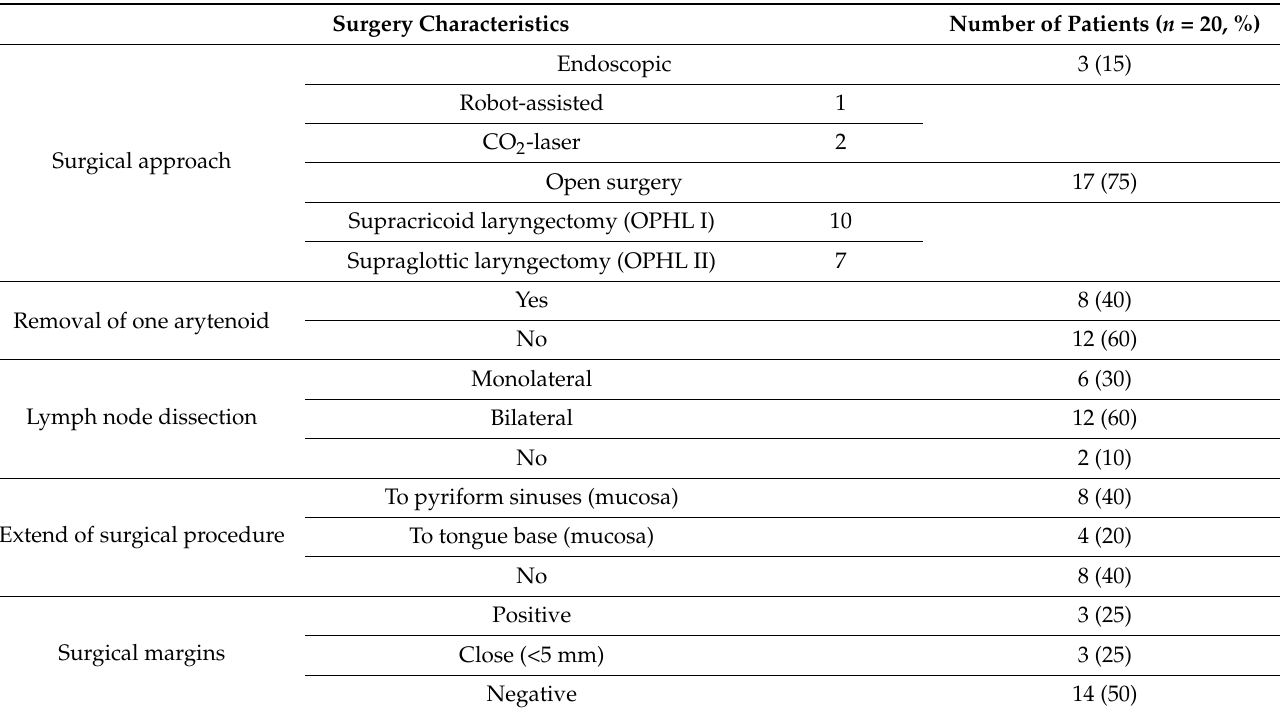
Table 2. Treatment